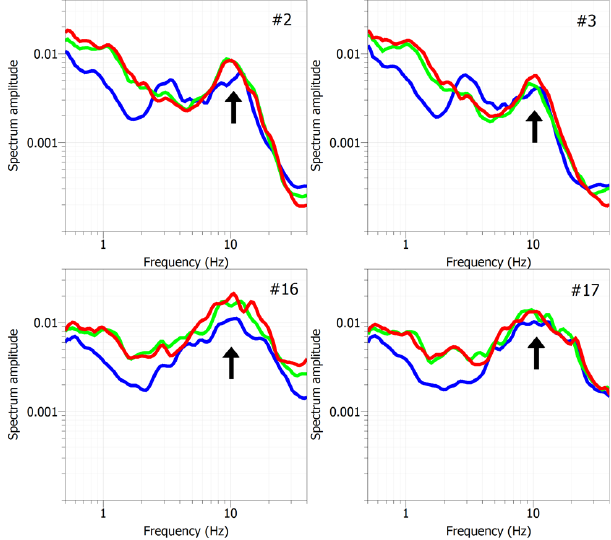
Fig. 11. Examples of Fourier spectra at representative ambient noise recording sites along the profile shown in Fig. 8. Blue, red and green lines refers to the vertical, N–S and E–W components of motion. The black arrow indicates the frequency range showing the rocking mode